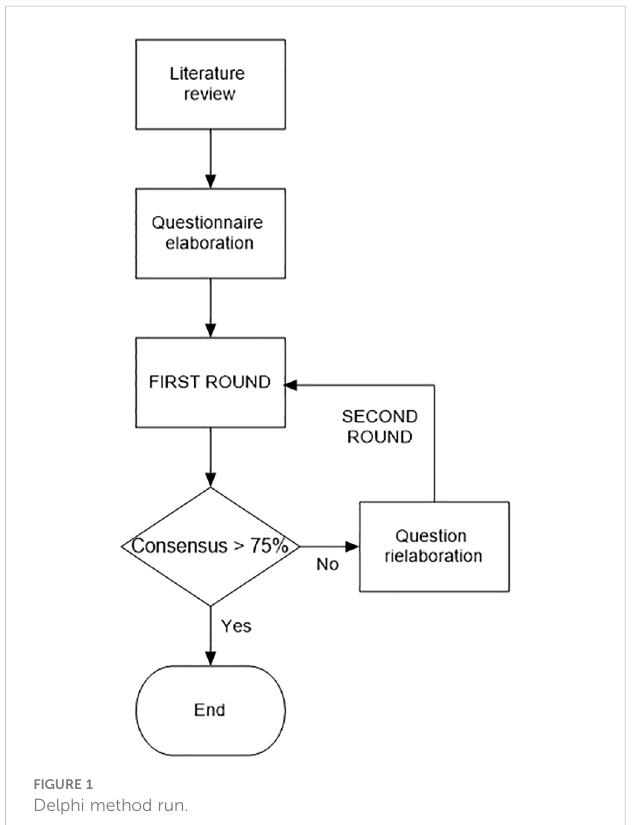
FIGURE 1 Delphi method